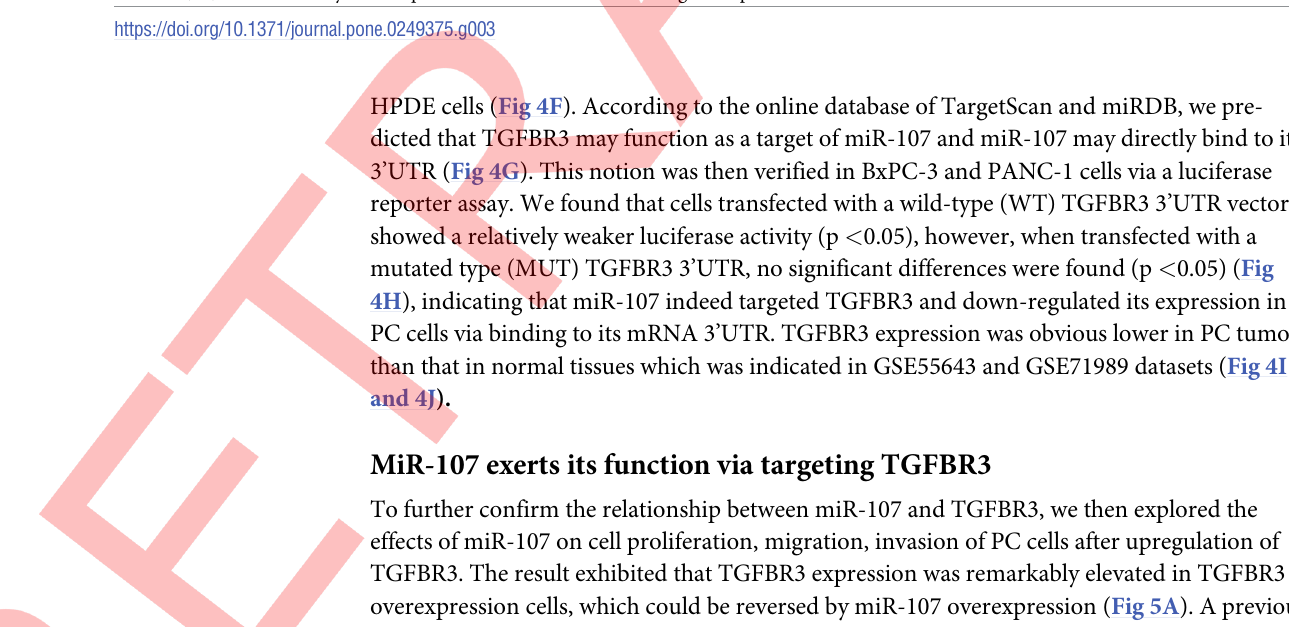
Fig 3. Impact of miR-107 overexpression on proliferation, invasion and migration of PC cells. A, QRT-PCR analysis of miR-107 in BxPC-3 and PANC-1 cells co-transfected with miR-107 mimic and miR-NC. B, cell proliferative capacity was measured based on MTT assay in BxPC-3 and PANC- 1 cells. C, D, Transwell assay was adopted to assess the invasion and migration power of BxPC-3 and PANC-1